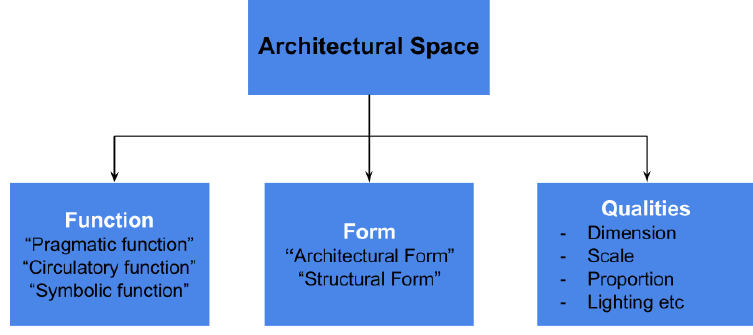
Figure 1. Architectural space and its components